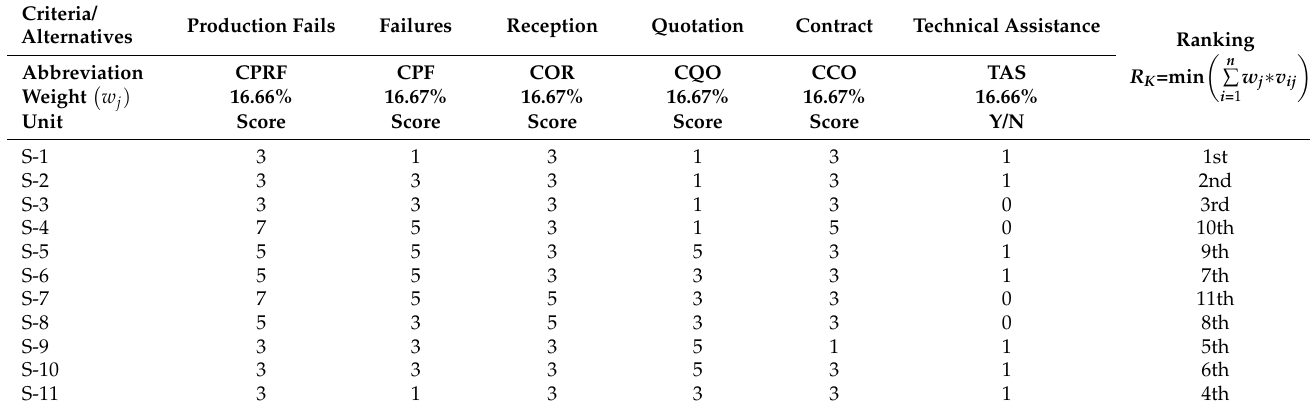
Table 6. Evaluation of Non-Monetary Criteria for Chemical